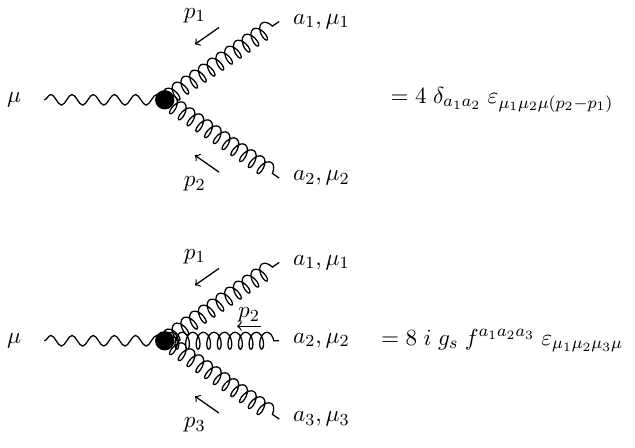
Figure 1 . Feynman rules for the current K µ in eq.